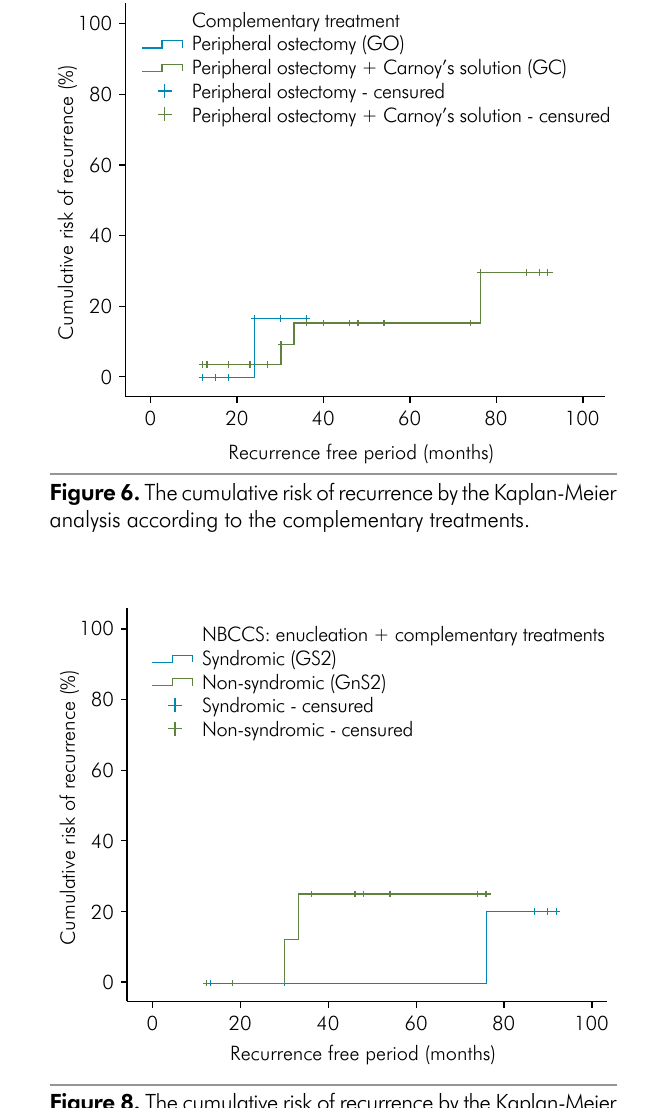
Figure 8. The cumulative risk of recurrence by the Kaplan-Meier analysis according to the association or lack thereof with the nevoid basal cell carcinoma syndrome for enucleation complemented by peripheral ostectomy and the use of Carnoy’s